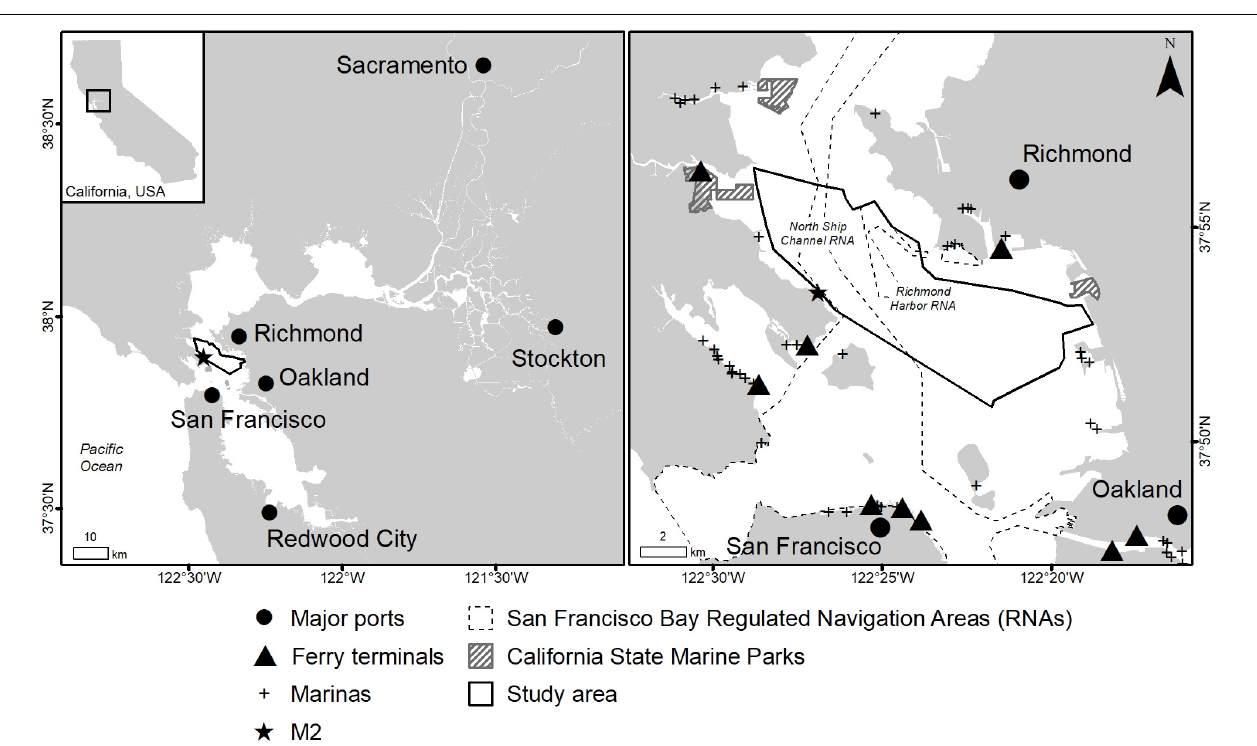
FIGURE 1 | San Francisco Bay Area (left) with study area in the Central Bay (right) indicated by the solid black line. Locations of major ports, marinas, protected areas (California Department of Fish and Wildlife [CDFW], 2008), and ferry terminals (Golden Gate Bridge, Highway and Transportation District, 2017; San Francisco Bay Ferry, 2018) are also shown. San Francisco Bay Regulated Navigation Areas (RNAs) were digitized according to 33 CFR 165.1181. Those lying within study area boundaries are the North Ship Channel RNA and the Richmond Harbor